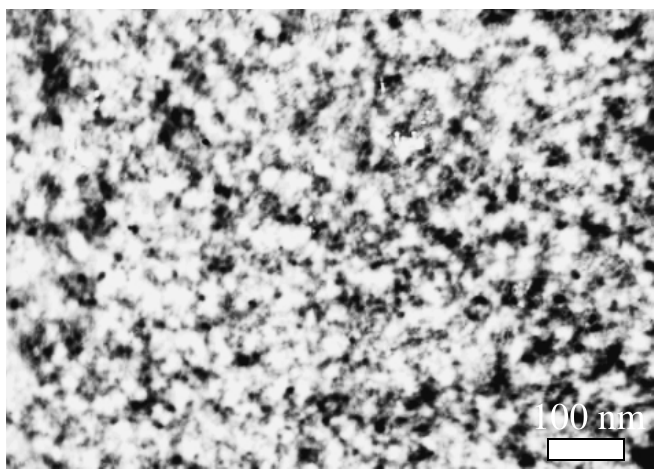
Figure 4. TEM image of SnO 2 film (Sph-500 sample). Minimal grain size ~4